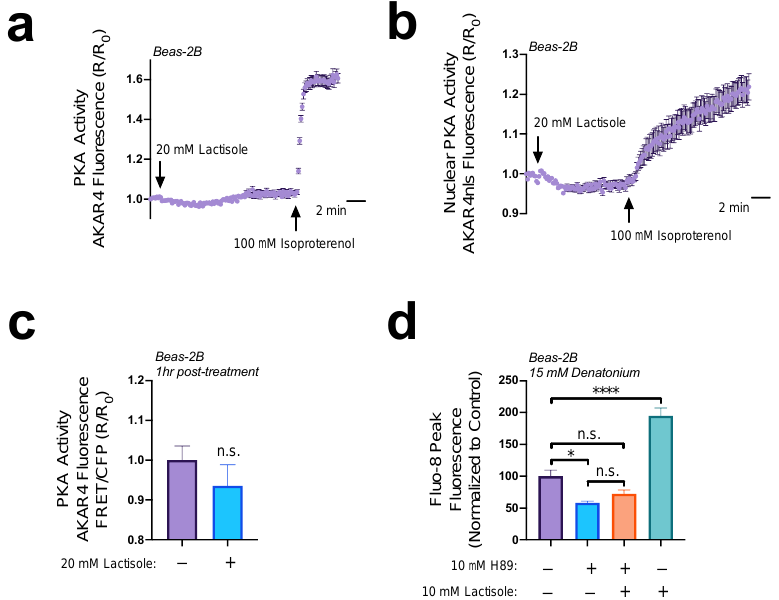
Figure 3. Lactisole cAMP elevations may not activate PKA. ( a ) The 20 mM lactisole did not alter PKA activity in Beas-2Bs expressing PKA biosensor AKAR4. ( b ) The 20 mM lactisole did not alter nuclear PKA activity in Beas-2Bs expressing nuclear PKA biosensor AKAR4nls. ( c ) lactisole (20 mM) did not alter baseline PKA activity even after a 1 h pre-treatment. ( d ) that PKA inhibitor H89 (10 µM, 1 h pretreatment) greatly impairs denatonium-induced Ca 2+ release even with 20 mM lactisole pre-treatment (1 h). Bar graphs containing 2 comparisons were analyzed via t -test; bar graphs containing >2 comparisons were analyzed via ANOVA using Bonferroni’s post-test for multiple comparisons * p < 0.05, **** p < 0.0001, “n.s.” represents no significance.